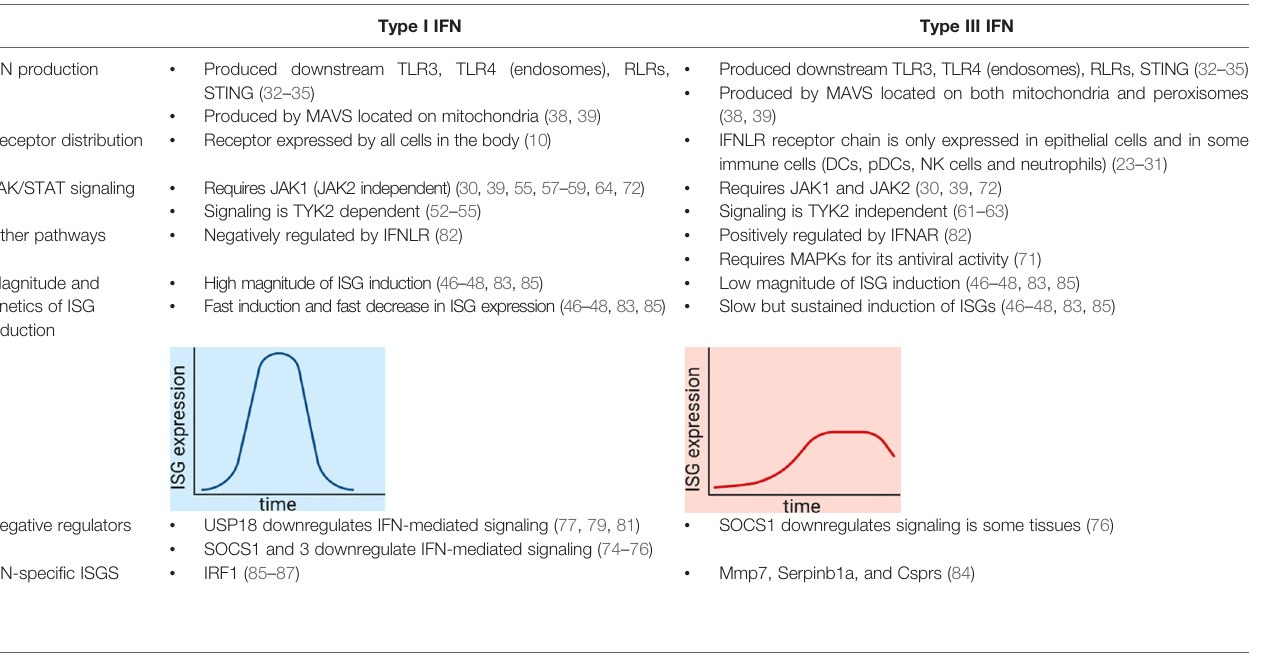
TABLE 1 | Similarities and differences of type I and III